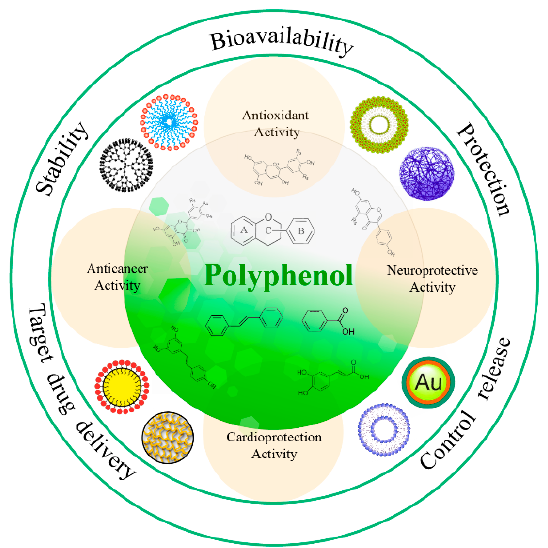
Figure 1. Schematic representation of nanoformulations to enhance the bioavailability and physiological functions of polyphenols.